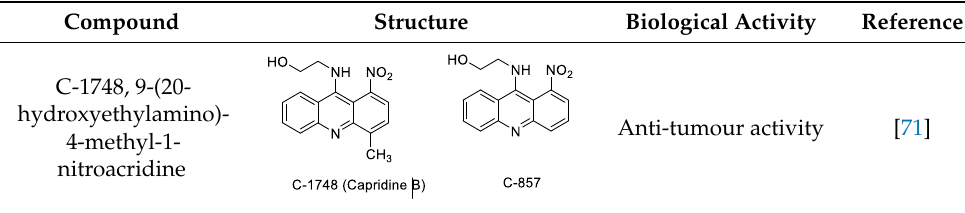
Figure 8. Mechanism of nitroacridine targeting various pathways. Table 10. Nitroacridine as an anti-tumour agent.